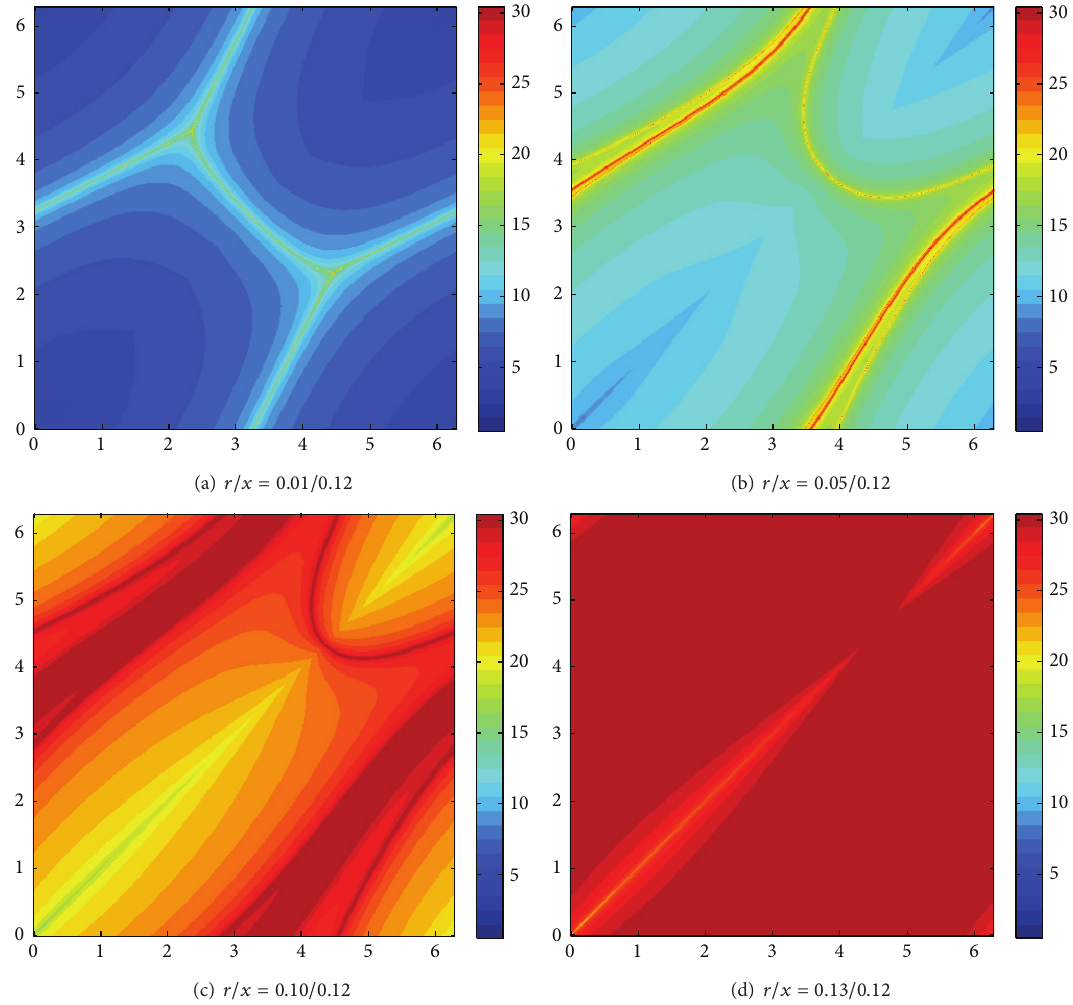
Figure 11: The convergence regions and the number of iterations required for the FDPF method to converge with different 𝑟/𝑥 ratios on the ( 𝜃 2 ,𝜃 3 ) plane: (a) 0.01/0.12 ; (b) 0.05/0.12 ; (c) 0.10/0.12 ; (d) 0.13/0.12 . The convergence region decreases in size with the increase in the 𝑟/𝑥 ratios; rendering the FDPF method does not work well in the distribution power networks which have high 𝑟/𝑥